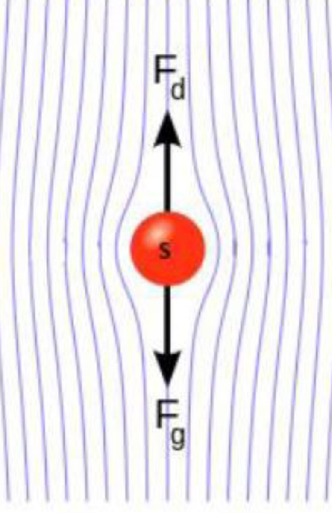
Fig. 8 Schematic of forces exerted on gas bubble immersed in electrolyte solution; F